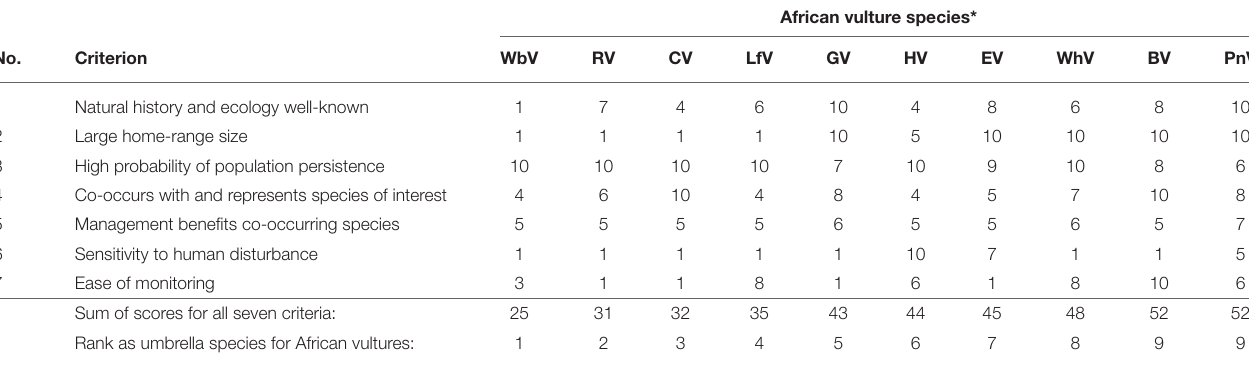
TABLE 6 | Assessment of the 10 African vulture species, according to the criteria of Seddon and Leech (2008) for an umbrella species.